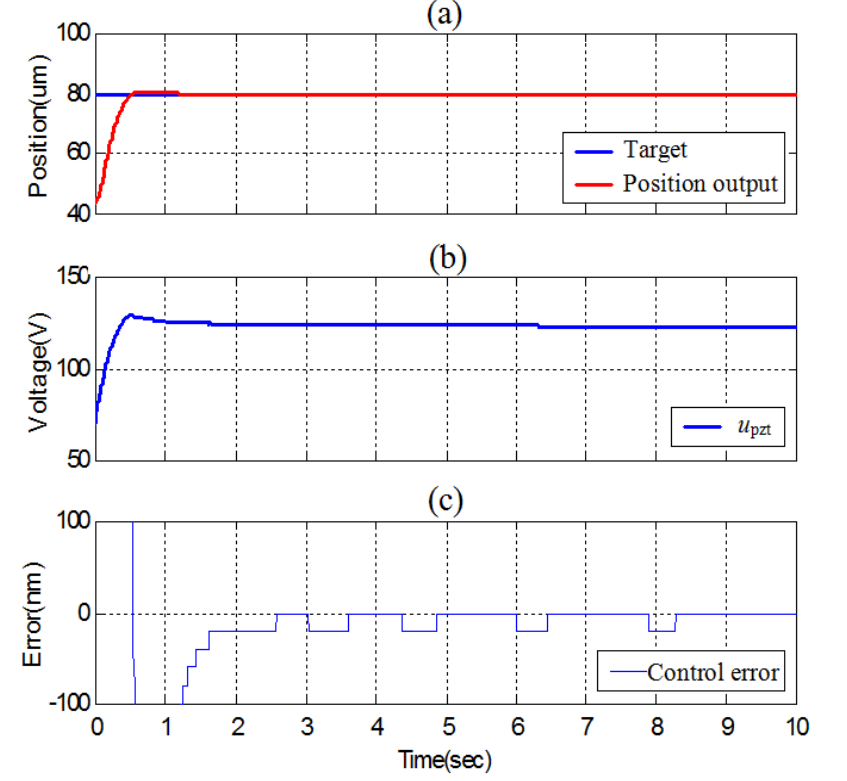
Figure 7. Experimental results of position control of the X-axial piezoelectric actuator with stroke of 80 μ m by SOFSMC: (a) position control response, (b) control signal, (c) control